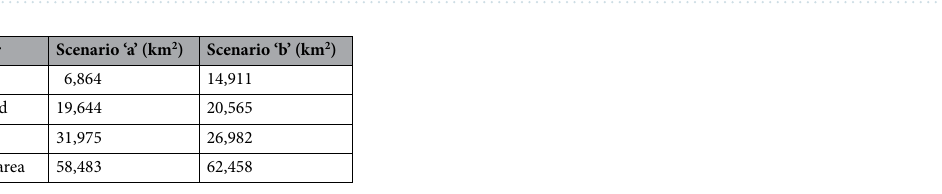
Figure 4. Sulawesi conservation features representativeness for all target scenarios (17%, 30%, and 50% protection target). The dashed line denotes the current protected area network on Sulawesi (18,602.4 km 2 ).